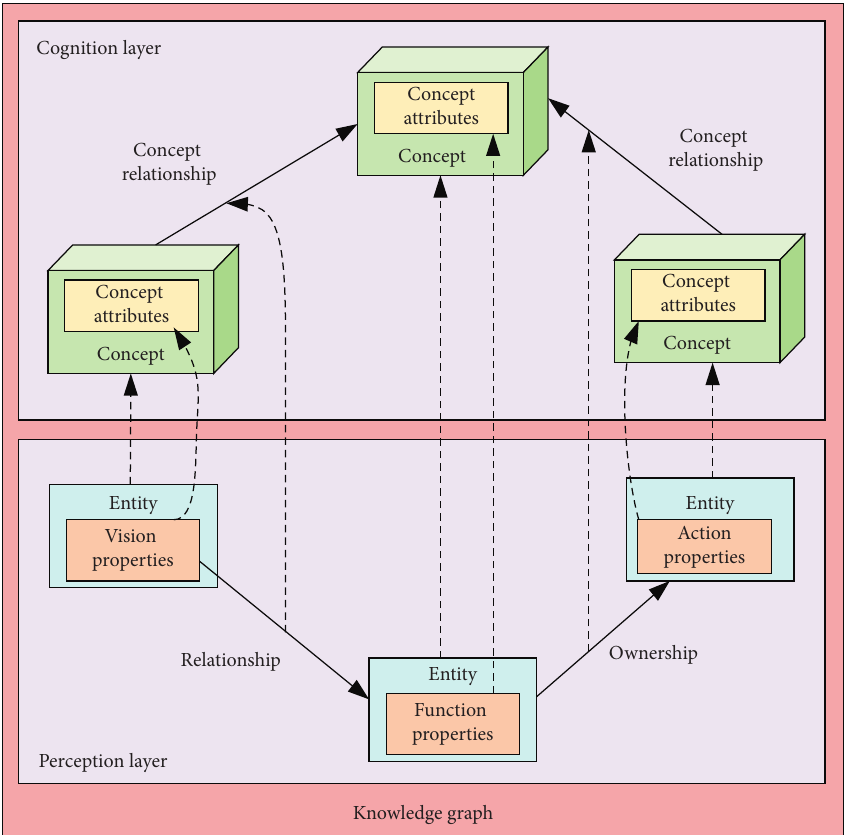
Figure 3: The relationship of knowledge graph and